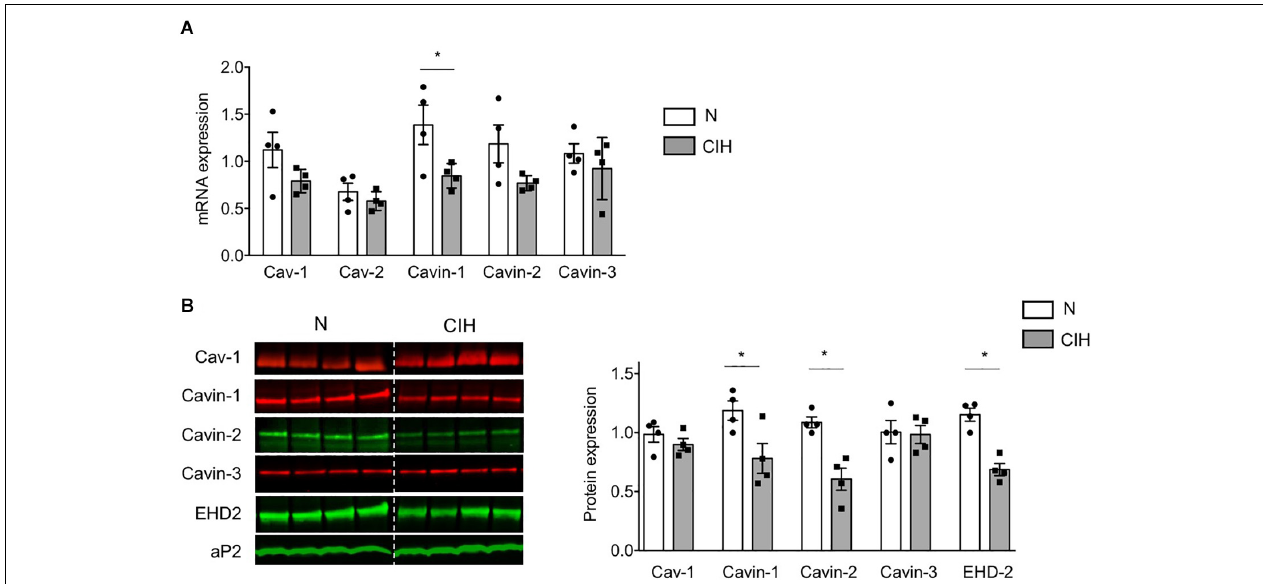
FIGURE 3 | Long-term CIH exposure specifically impacts cavin expression. (A–C) mRNA expression of caveolar proteins was determined by quantitative RT-PCR (A) and caveolar protein expression by western-blot (B,C) in epididymal WAT of mice exposed to Normoxia (N) or CIH for 6 weeks. Quantification of relative mRNA expression of Caveolin-1 (Cav-1), Caveolin-2 (Cav-2), Cavin-1, Cavin-2, and Cavin-3 (normalized to GAPDH mRNA expression) is presented in panel (A) ( n = 4 mice per condition). Immunoblots of caveolar protein expression are presented in panel (B) . The dash line separates normoxic (N) and 6 weeks-CIH samples, run on the same blot, but not loaded adjacently. Quantification of caveolin-1/Cav-1, cavin and EHD2 relative protein expressions (normalized to aP2 protein) are presented in panel (C) , as mean ± sem with dot plots representing relative protein signal for each mouse explored. Significant differences between conditions was evaluated by Student t -test, * p < 0.05 vs. normoxic